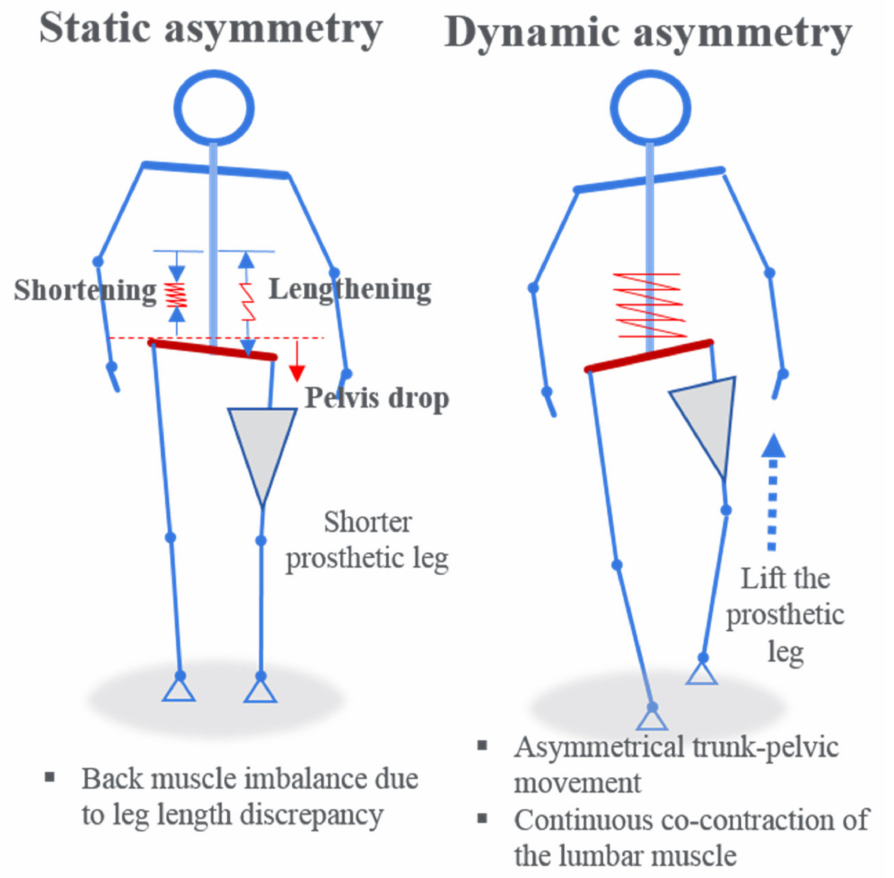
Figure 1. Schematic of static and dynamic contributing factors associated with lumbar muscle imbalance in patients with unilateral transfemoral